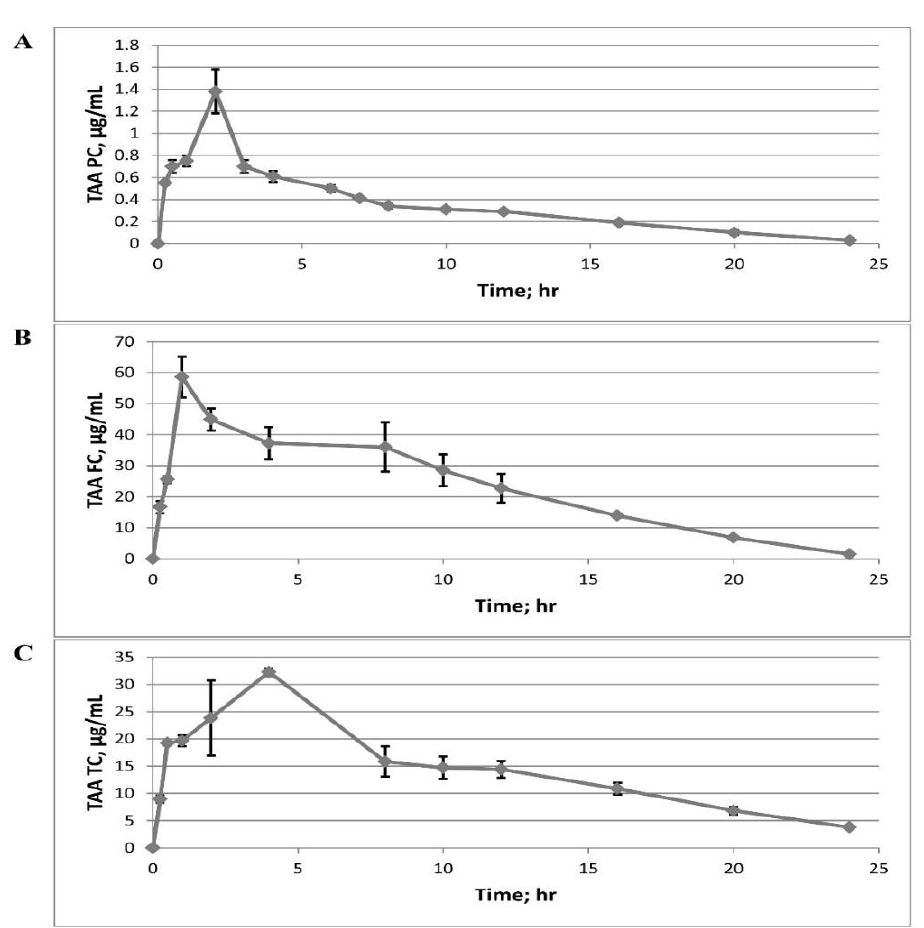
Figure 10. TAA concentration in ( A ) plasma, ( B ) lung fluid, and ( C ) lung tissue after insufflation of 5 mg from dry powders to rats. Mean ± SE, n = 3 at each time point.